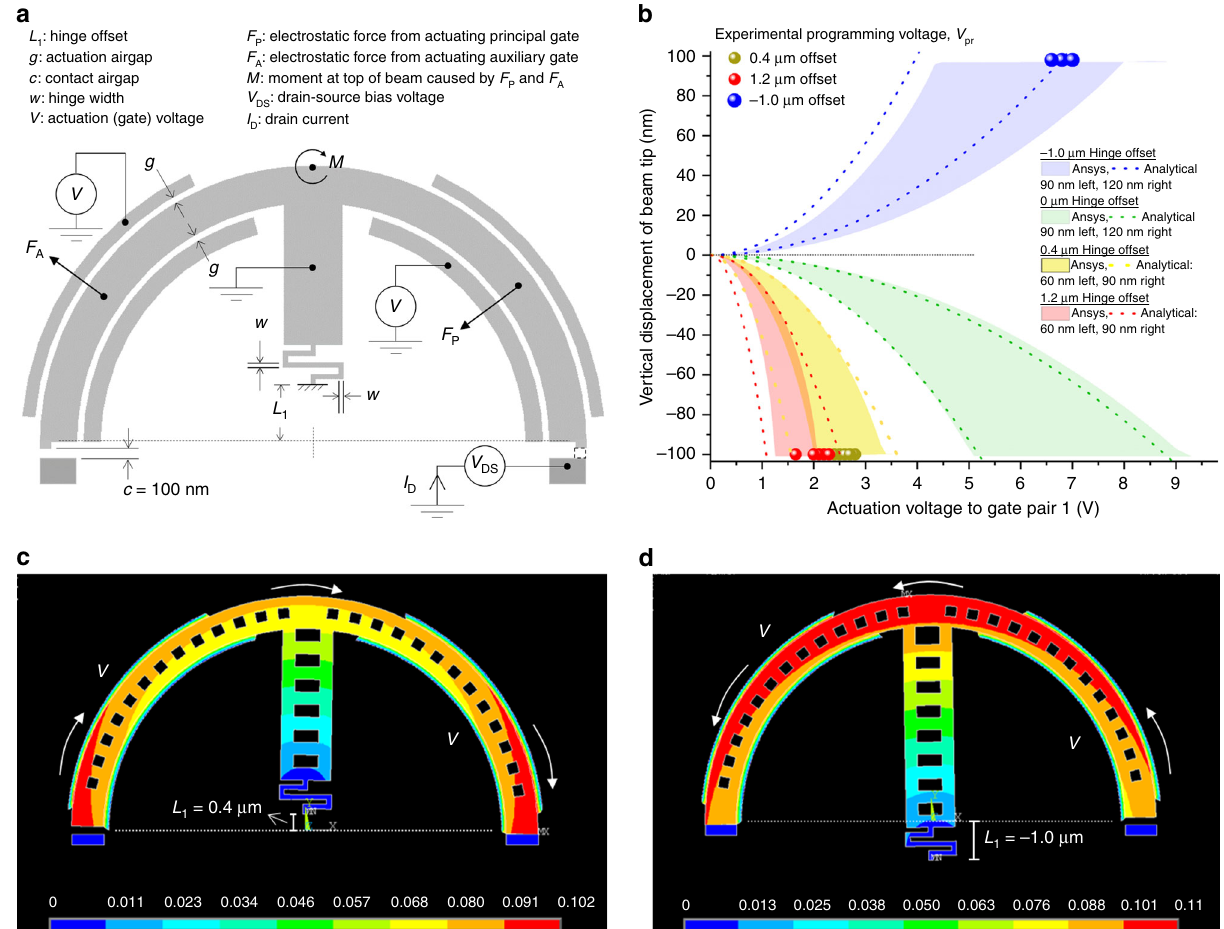
Fig. 2 Forces and rotation moments in relay with serpentine hinge. a Relay with a positive hinge offset L 1 , de fi ned as the vertical displacement of the hinge anchor point from the geometric centre of the circular beam. A negative hinge offset would result in the hinge anchor point being situated below the centre. When a voltage V is applied simultaneously on the principal and auxiliary gate pair 1, the resultant electrostatic fi elds across the two respective airgaps produce radially directed forces as shown. These forces resolve to realise a net clockwise rotational moment for positive hinge offsets, and an anticlockwise rotational moment for negative hinge offsets. b Measured programming voltages (circles) for different hinge offsets where the beam tip moves down 100 nm vertically to make contact with the drain. Multiple devices with the same hinge offset were tested with the differences in programming voltage due to fabrication non-uniformities across the die. Also shown are the predictions from the analytical model (dashed lines, model described in Supplementary Note 1 and Supplementary Fig. 1) and Ansys fi nite-element model (bands) for a range of hinge widths. Other than the hinge offsets, the geometry of the devices are identical and shown in Supplementary Table 1. c , d Ansys simulation of the total displacement for different hinge offsets of otherwise identical devices where the device is actuated in both instances by driving principal and auxiliary gate pair 1. The colour bar represents vertical displacement with red corresponding to 100 nm, the drain-to-beam-tip